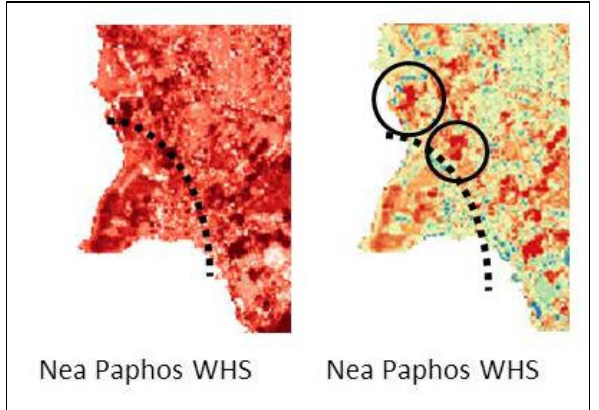
Figure 8 Difference in C-factor over nearly last 30years observed false colour, detail over Nea Paphos Cultural Heritage site (left) and with overlaid significant LULC areas obtained from NDVI calculations